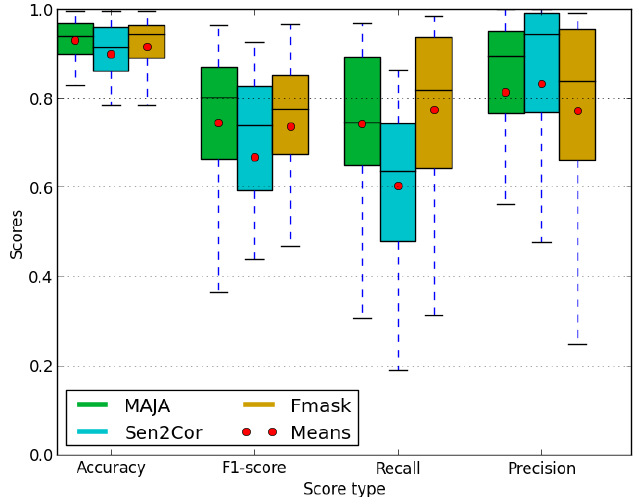
Figure 8. Mean and box plot of each metric for the original version of the cloud masks of Sen2Cor and FMask and of the eroded version of MAJA over the 32 scenes, compared to the non-dilated ALCD cloud mask. Red dots correspond to average values and the horizontal bars in the colored box to the 25%, 50% (median), and 75% quartiles. The dashed lines extend to the minimum and maximum